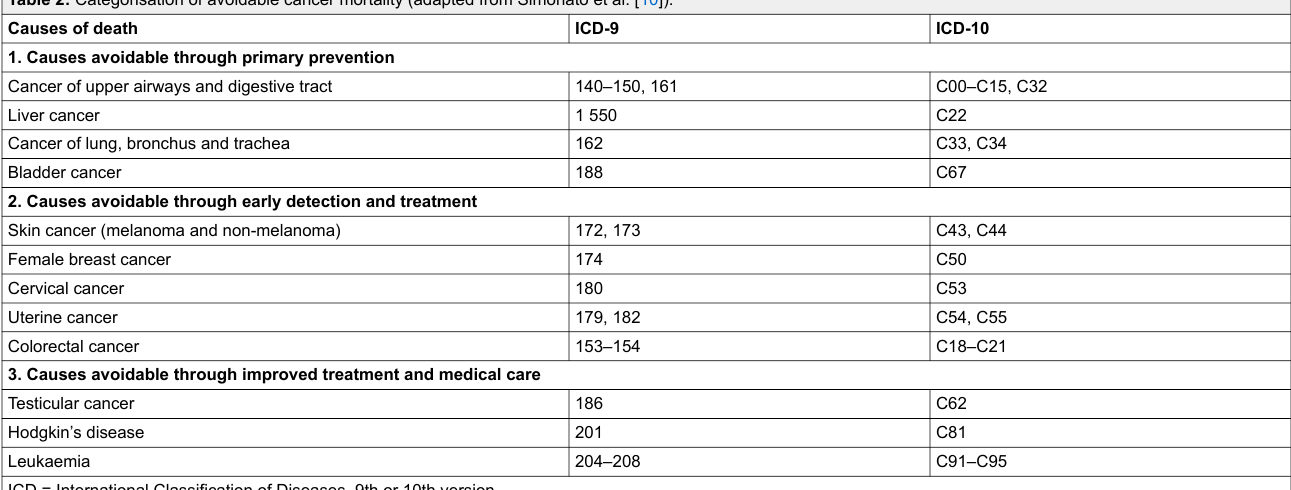
Table 2: Categorisation of avoidable cancer mortality (adapted from Simonato et al. [10]). Causes of death